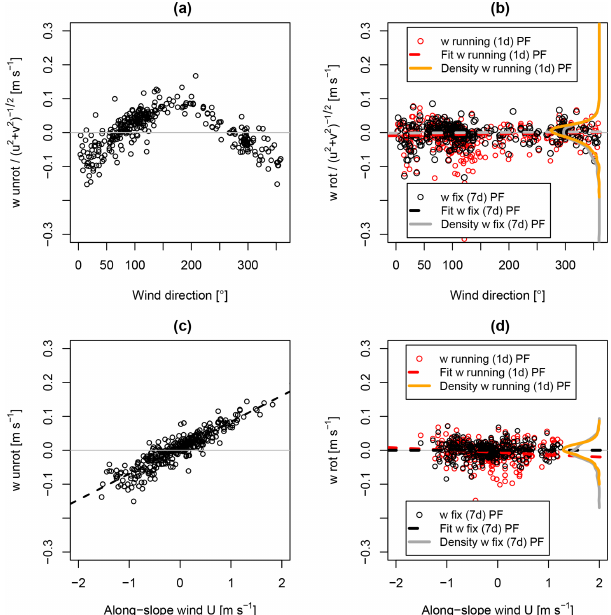
Figure 16. 30min means of vertical wind velocity, w , before (a, c) and after (b, d) coordinate rotation as a function of wind direc- tion (a, b) and as a function of along-slope wind, U (c, d) . The vertical wind velocity w in (a) and (b) is normalized by horizon- tal wind velocity. Panels (b) and (d) both differentiate between two approaches to the planar-fit coordinate rotation: the real-time planar fit applied in the TEA measurements, deploying a moving window of 1d (“running PF”, in red and orange), and a single planar fit, covering the full measurement period (7d long) obtained in post- processing (“fix PF”, in black and gray). The labels “rot” and “un- rot” denote the rotated and unrotated vertical wind velocities, re-